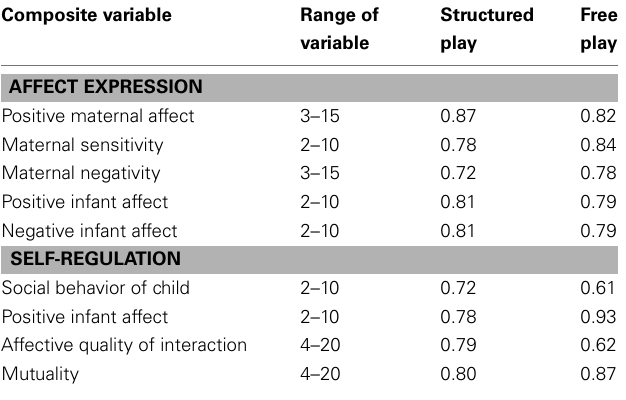
Table 2 |Affect expression and self-regulation composite variables: Cronbach’s alpha coefficients during structured play and free